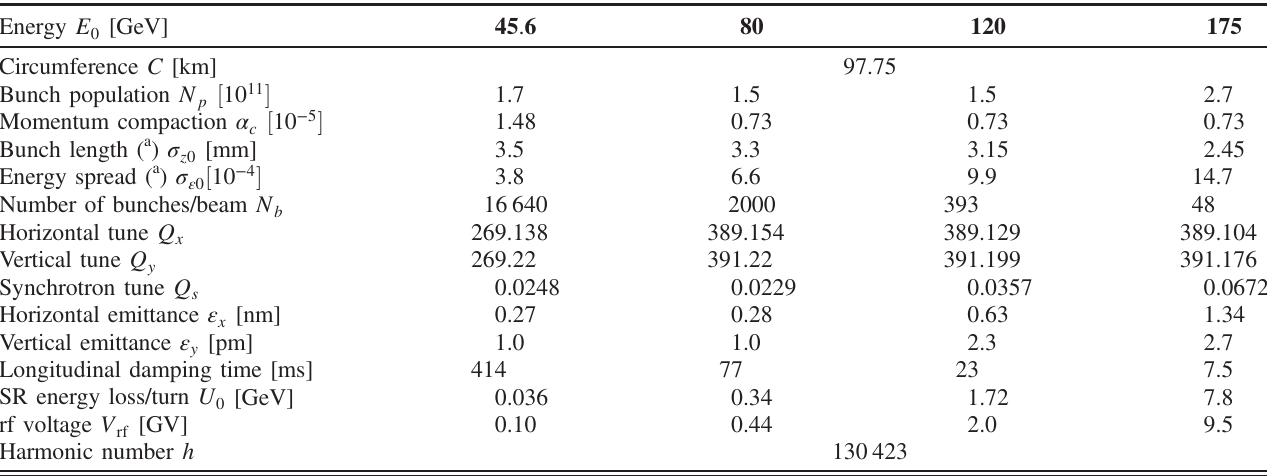
Number of bunches/beam N